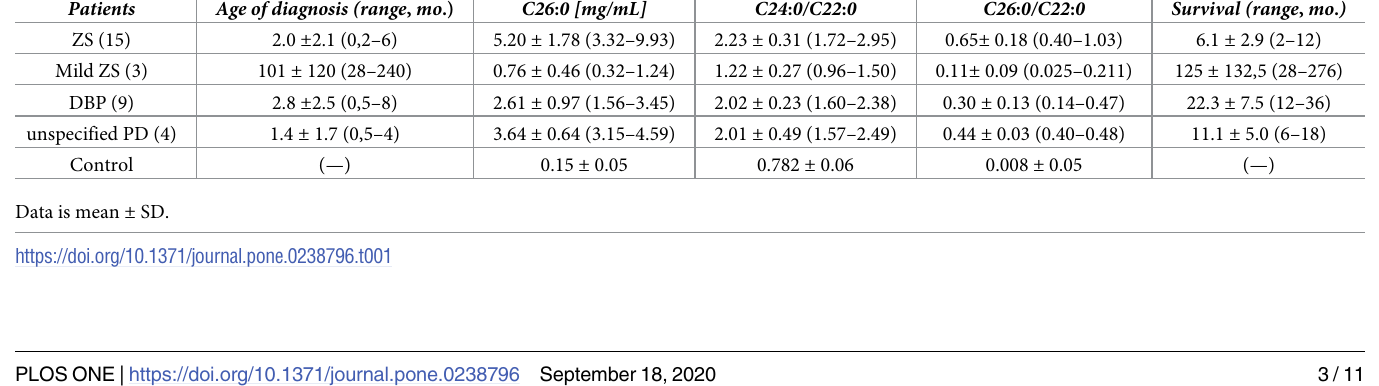
Table 1. VLCFA levels, age diagnosis and survival in patients with peroxisomal disorders.